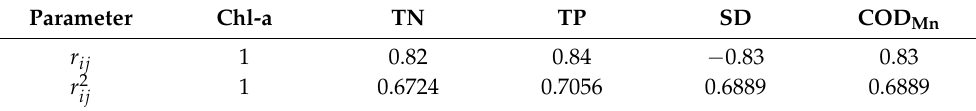
Table 1. Correlation coefficient for Chl-a to other parameters in Chinese lakes and reservoirs. Parameter Chl-a TN